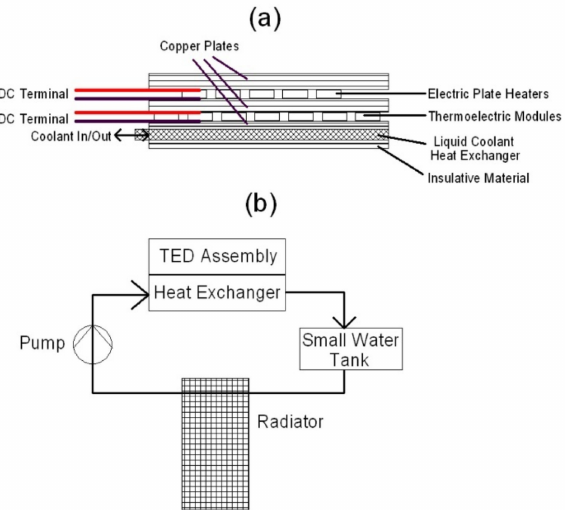
Figure 7. Details of the experimental platform ( a ) TED layers, ( b ) liquid cooling system [70]. Reprinted from Control Engineering Practice, Complete implementation of the combined TEG-TEC temperature control and energy harvesting system, Trevor Hocksun Kwan, Xiaofeng Wu, Qinghe Yao, 95 , 104224, Copyright 2019, with permission from